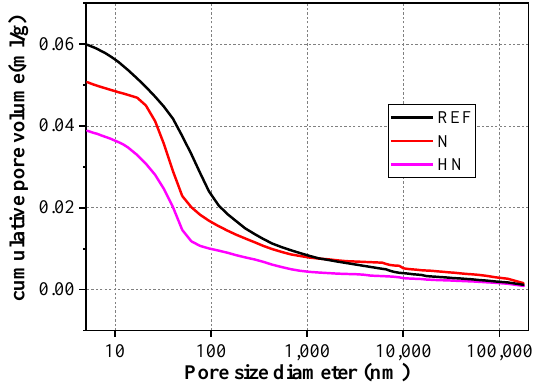
Figure 9. Pore size distribution of different samples.